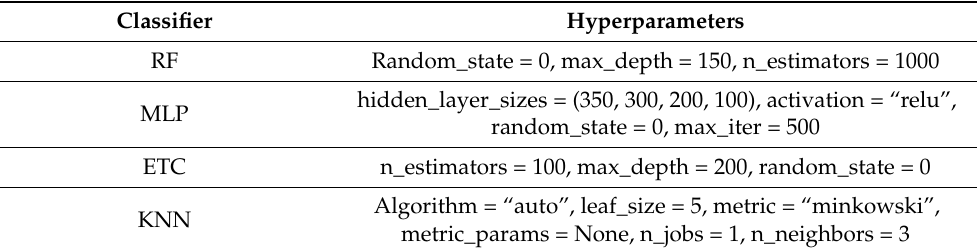
Table 1. Parameters used to tune classifiers.